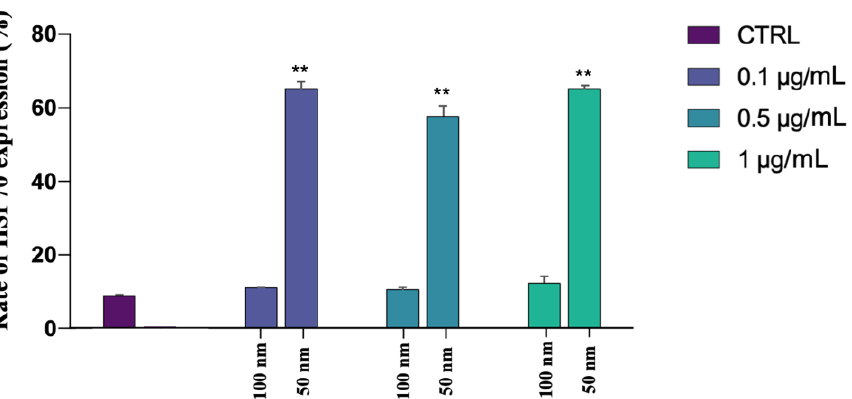
Figure 9. Mean percentage of spermatozoa that expressed HSP70 after the exposure (30 min) to 50 and 100 nm PS-NPs at increasing concentrations. Approximately 400 spermatozoa were counted in five different fields for each sample. In addition, two replicates were performed, in a total of 8 samples and 3200 spermatozoa analyzed. Strong statistically differences (** p < 0.01) have been found between samples exposed to all concentration of 50 nm PS-NPs compared to the control group.